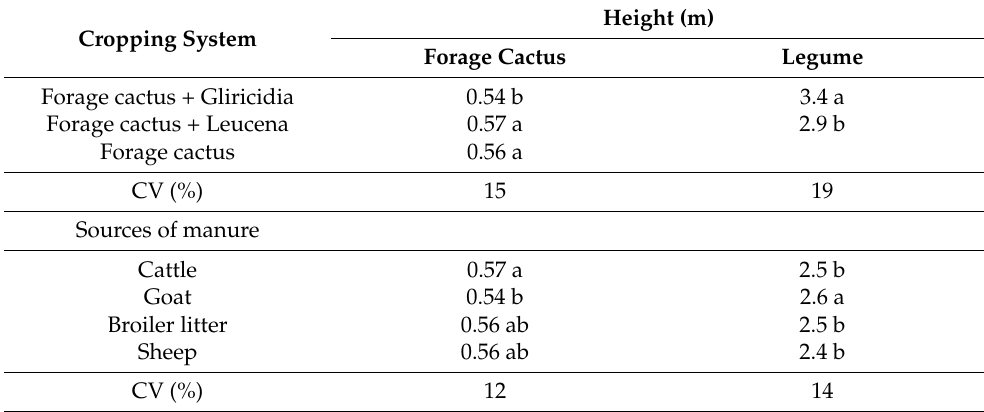
Table 7. Height of forage cactus and legume in different cropping systems and manure sources. Cropping